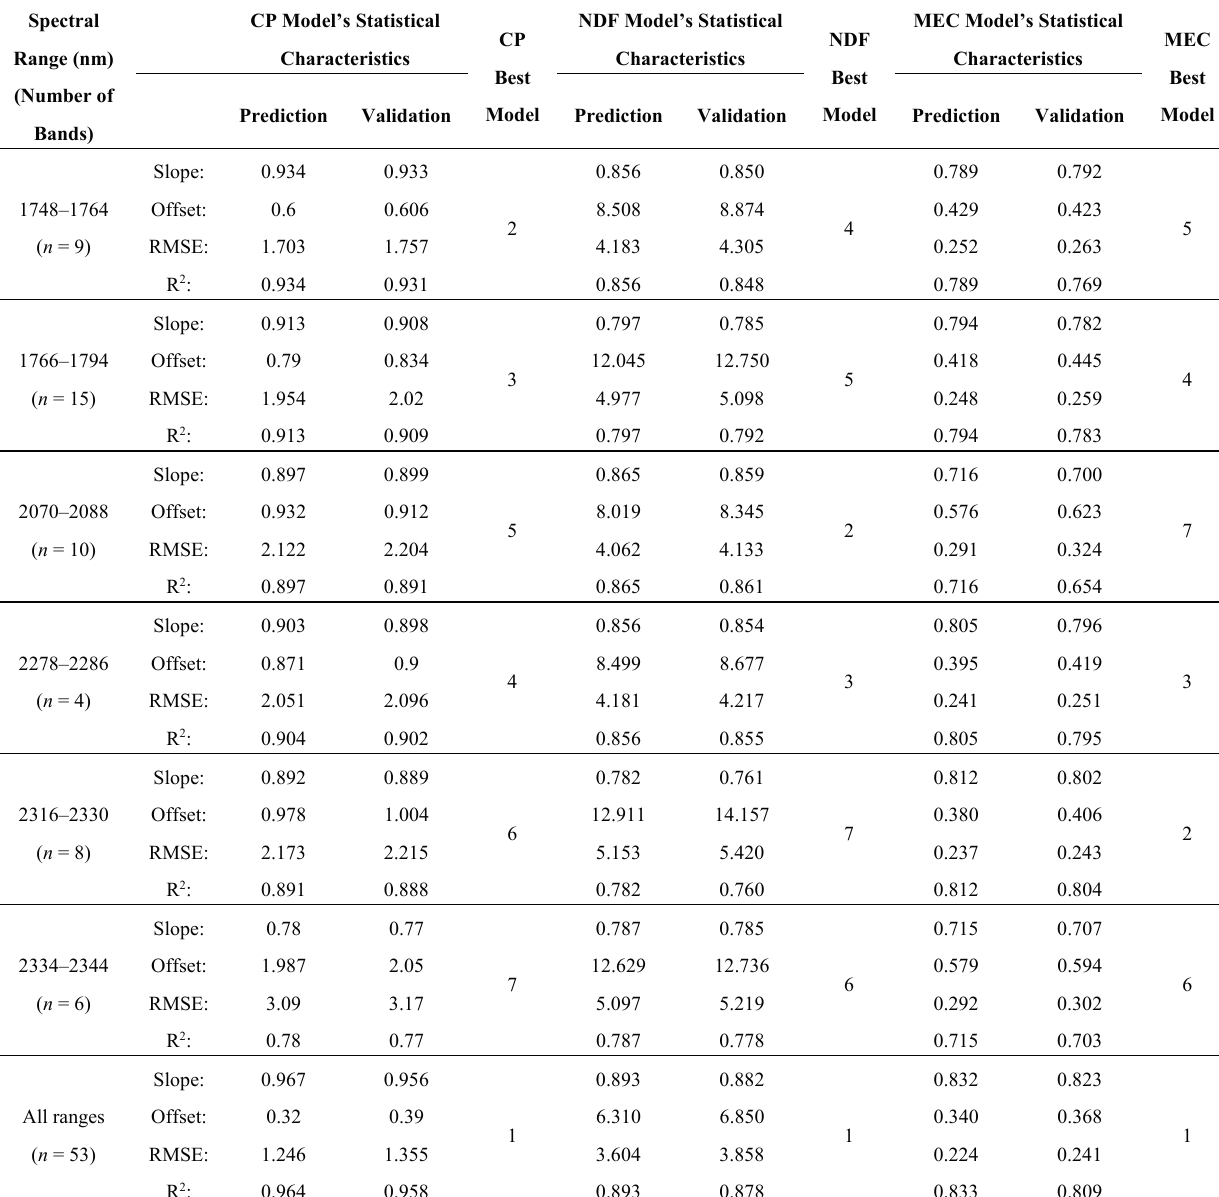
Table 5. Partial least squares (PLS) regression model results of the correlations between different spectral regions and percentages of CP, NDF and